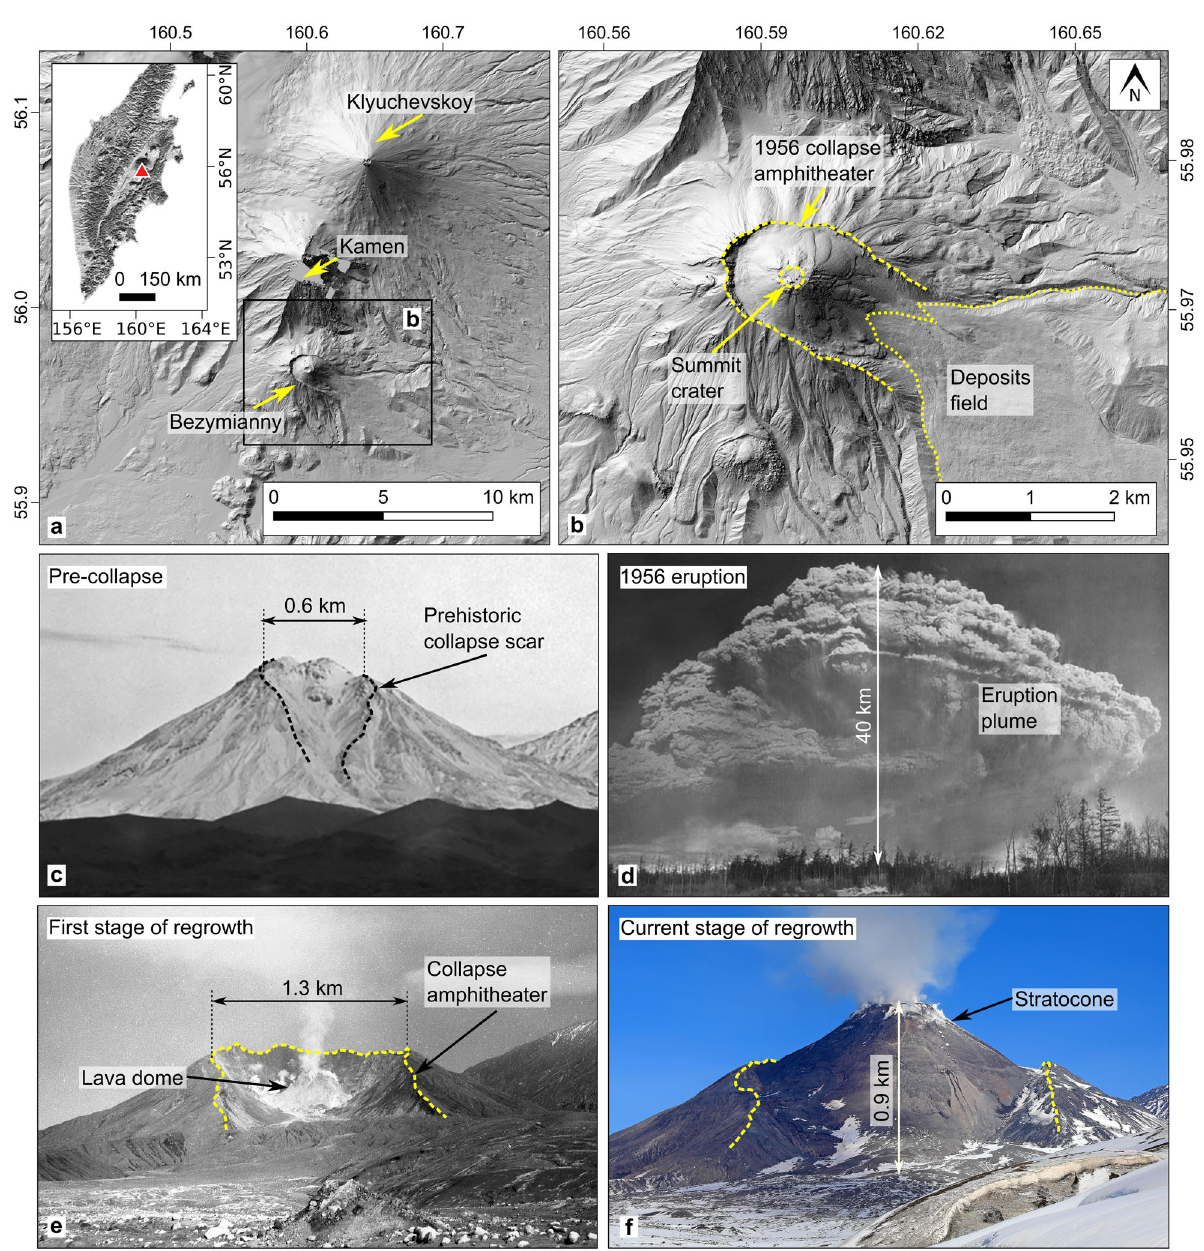
Fig. 1 Bezymianny volcano and photo documentation of the edi fi ce before, during, and after the 1956 sector collapse. a Location of Bezymianny volcano in the Kluchevskaya volcanic group; inset shows the location in the Kamchatka Peninsula. b Shaded relief map of Bezymianny. c State of Bezymianny in 1909 showing the scar of an earlier, albeit smaller collapse. d The 30.03.1956 eruption. e Bezymianny in August 1956. f Bezymianny on 13.04.2019. c , e , f views from the southeast. d view from the west. Map data: a 2018 ArcticDEM digital elevation model (https://www.pgc.umn.edu/data/arcticdem/), b 2017 Pleiades digital elevation model. Photos: c by N. G. Kell, d by I. V. Yerov, e by G. S. Gorshkov, and f by Yu. V.